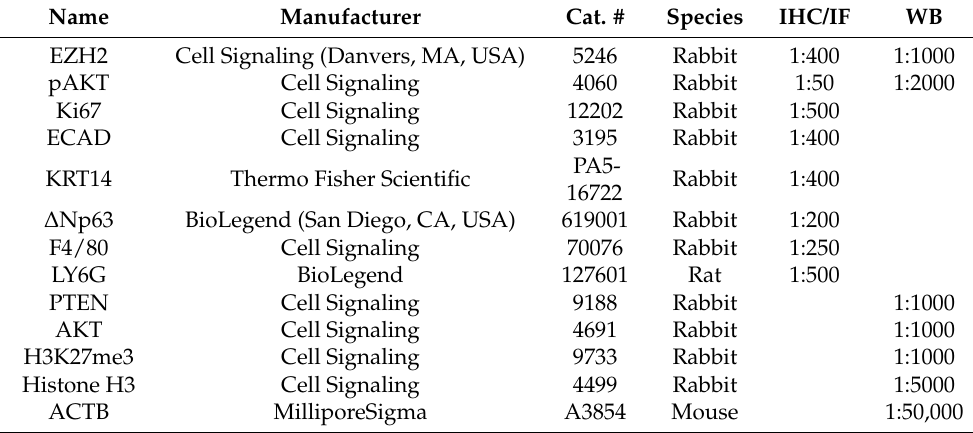
Table 1. Information of primary